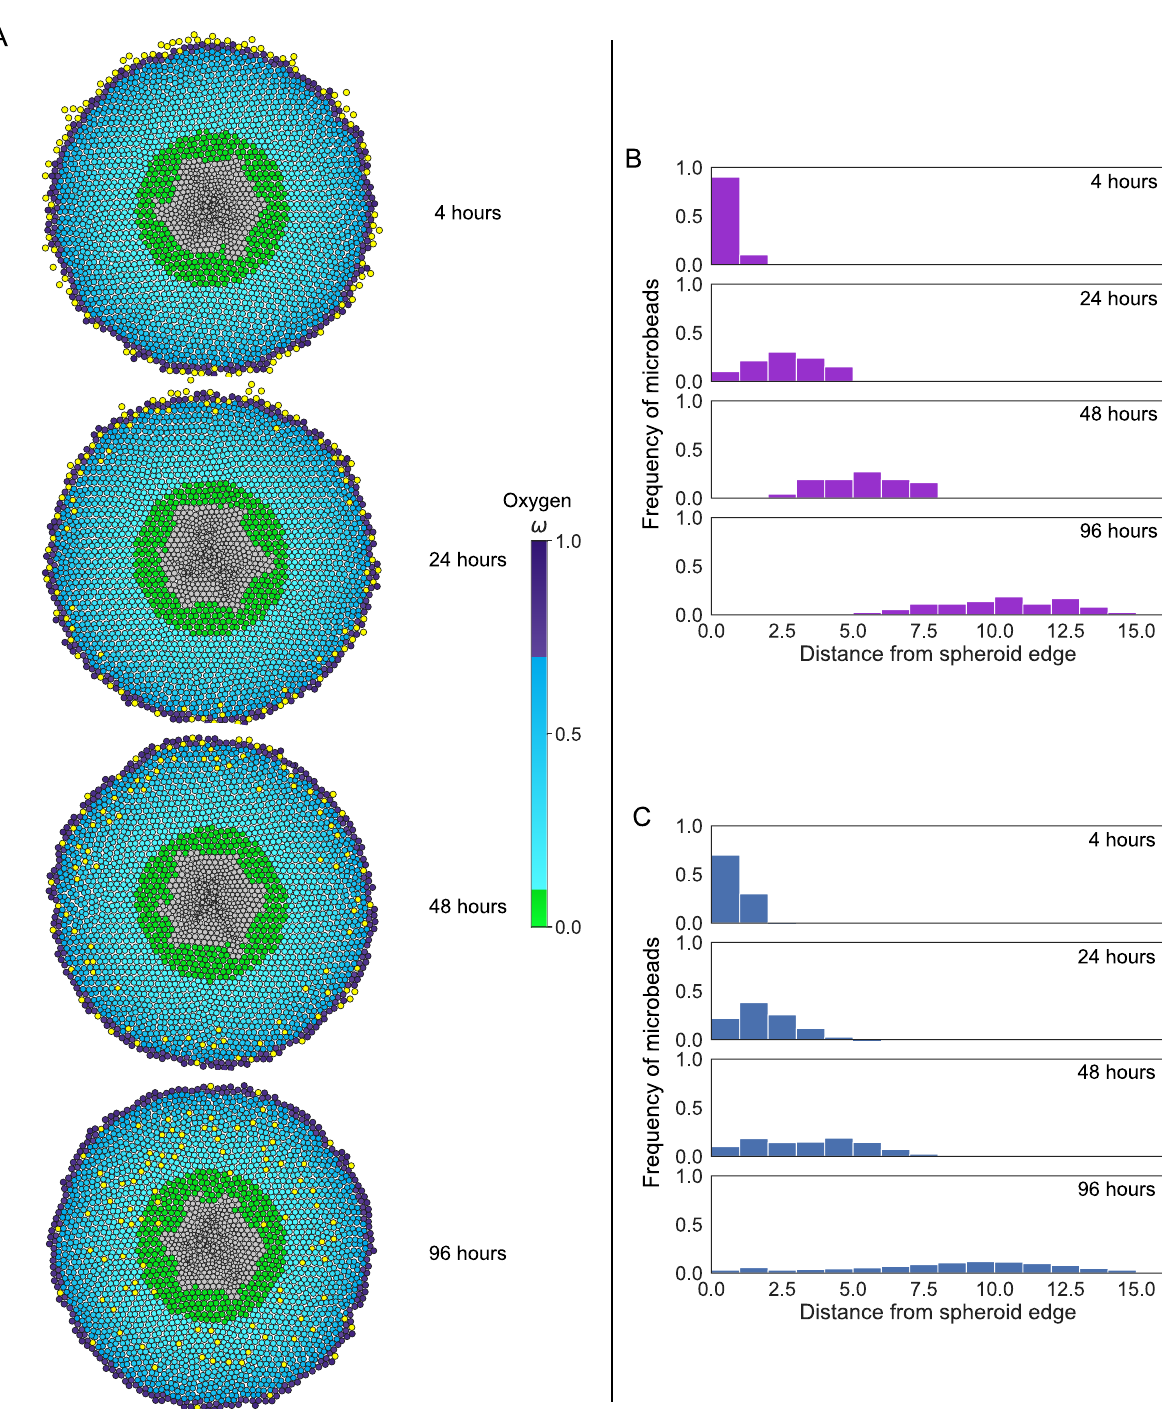
Fig 3. Model validation II: reproducing microbead infiltration patterns. A: Realisations of a typical simulation showing microbead infiltration (yellow circles) over time. Microbeads were added to the spheroid after 300 simulation hours, and permitted to infiltrate the spheroid for a further 100 hours. Times stated are times after microbeads were added. Tumour cells are coloured according to their phenotype (see Fig 1). Parameter values ω q = 0.7, ω h = 0.1, τ = 8, ~ t ¼ 16 . B: Frequency histograms showing the experimentally observed distribution of microbeads in spheroids (reproduced from Fig 7 of Dorie et al . [46]. C: Frequency histograms showing the distribution of microbeads in spheroids generated from this model, averaged over 40 iterations of the parameter set in A. For this parameter set, the distribution of microbeads closely resembles that in Panel B. Histograms showing the distributions obtained for different parameter sets can be seen in S4 Appendix: Microbead infiltration histograms for other parameter combinations.